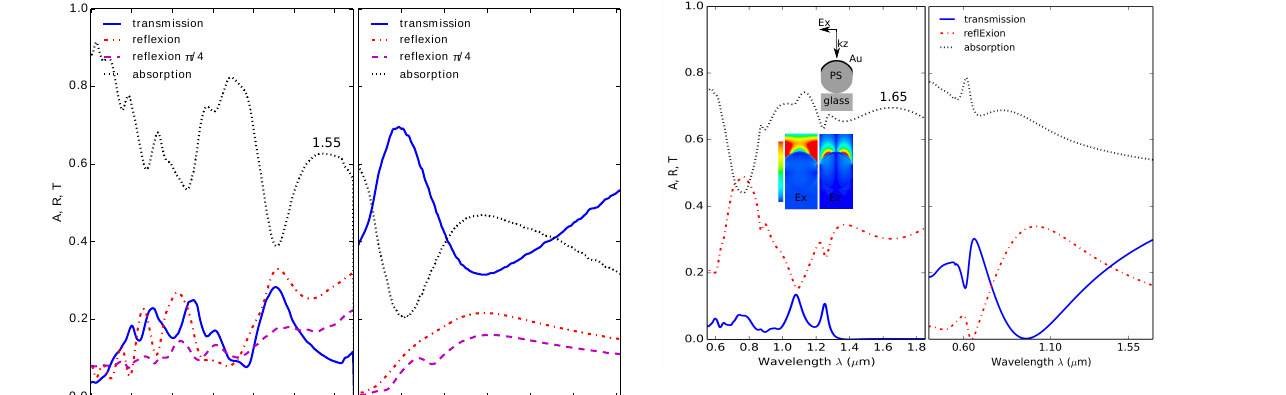
Figure 3: Simulations. Transmission (T, blue solid line), reflection (R, red dashed-dotted line) and absorption (A, black dotted line) spec- tra of the HPPS (left, absorption maxima are at 1.1 µ m and 1.65 µ m) and NPA (right, note the absorption maximum at 1 µ m). The insets show a cut in the xz plane of the geometry (in gray–black) of the HPPS and the E x and E z near-field patterns (in color) at the wave- length of the incident entangled photons ( λ = 1.552 µ m). Light is polarized along the x axis and propagates along the z axis. The color scales from blue (minimum intensity) to red (maximum inten-